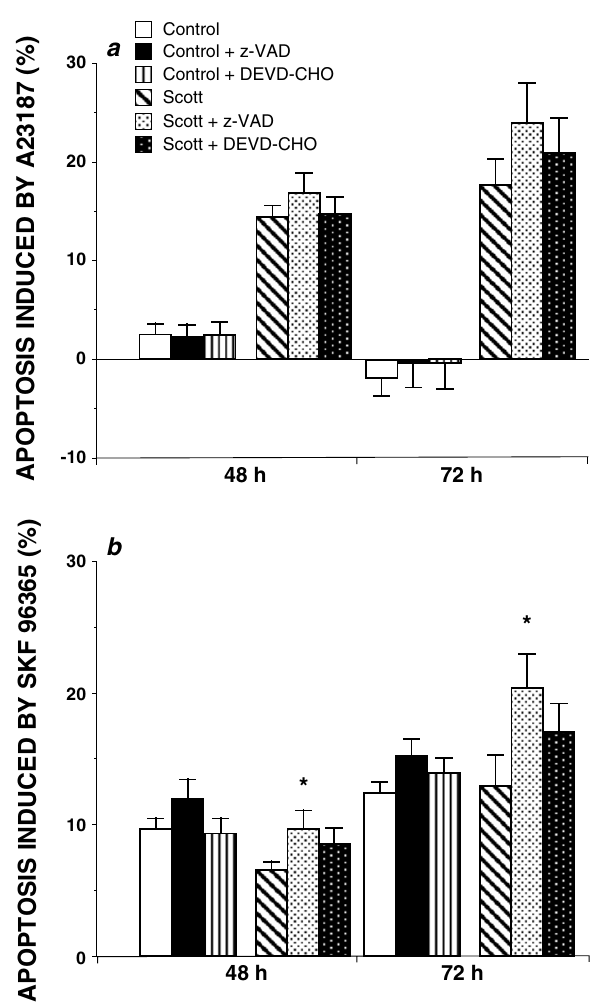
Figure 3 Effect of the caspase inhibitors z-VAD.fmk or Ac-DEVD- CHO on cell death induced by calcium ionophore A23187 or calcium channel inhibitor SKF 96365. Control and Scott B lymphoblasts were treated with z-VAD.fmk (50 µ M) or Ac- DEVD-CHO (50 µ M) for 48 or 72 h in the presence of cal- cium ionophore A23187 (200 nM) (a), or in the presence of the calcium channel inhibitor SKF 96365 (10 µ M) (b). The degree of apoptosis was determined by measurement of hypodiploid DNA using propidium iodide (0.1 mg/ml). Values are mean ± SEM of at least 8 independent determinations. * P < 0.05 versus the corresponding value in the absence of cas- pase